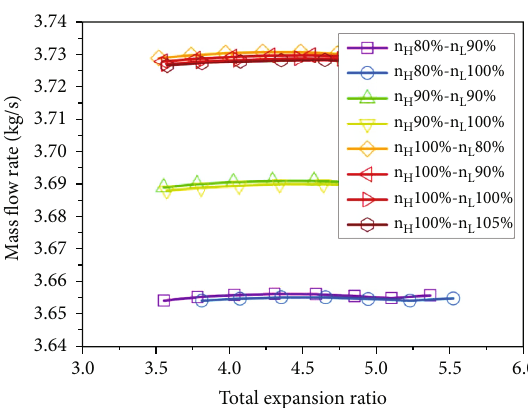
Figure 15: Mass fl ow rate characteristics at di ff erent